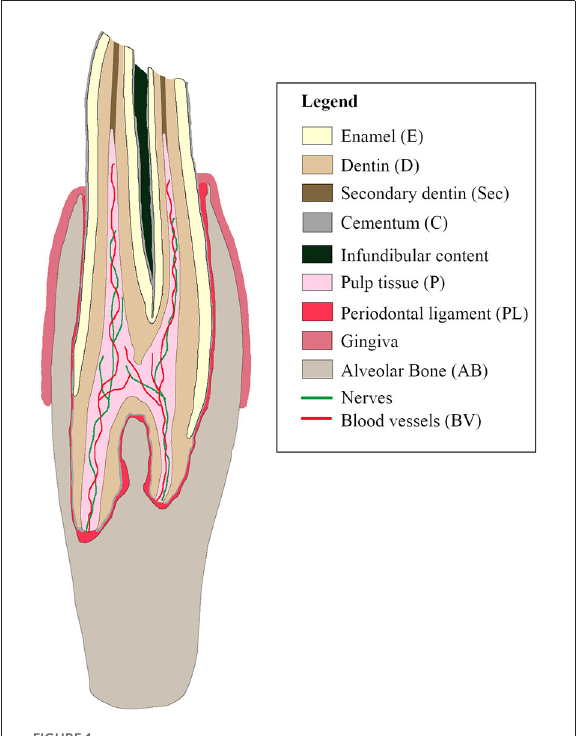
FIGURE1 Schematic sagittal representation of a normal cheek tooth in the